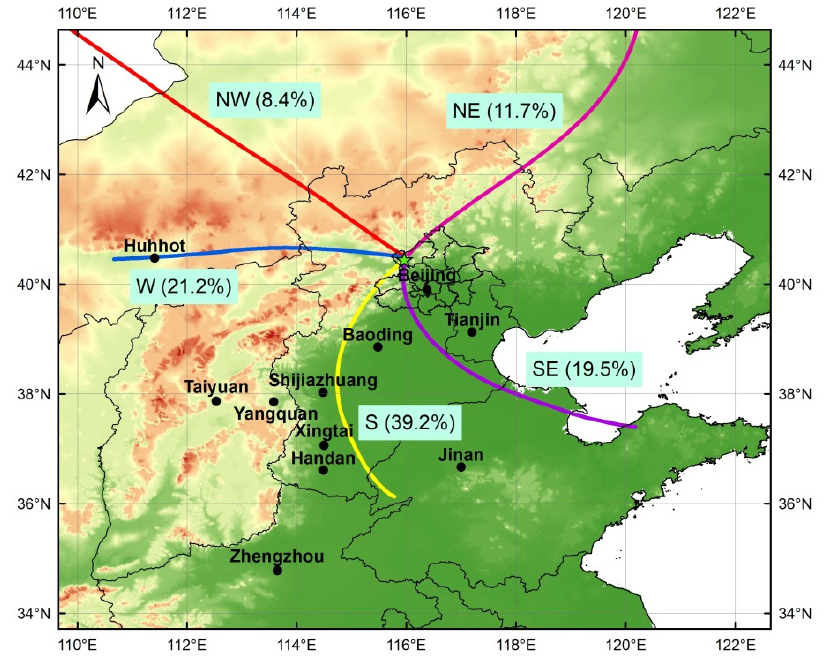
Figure 1. The sampling location (denoted as a star) in the North China Plain. Statistical cluster analysis of air mass backward trajectories showing pathways of air parcels prior to arrival at the sampling site. The percentage of trajectories occurring in each cluster is also shown along the pathways, including northwest (NW, 8.4%), west (W, 21.2%), south (S, 39.2%), southeast (SE, 19.5%) and northeast (NE, 11.7%).